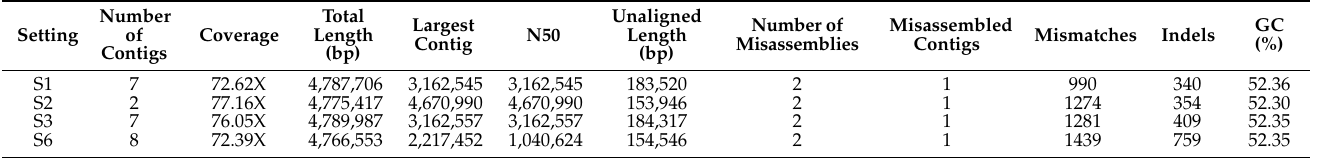
Table 4. Results of QUAST assembly quality assessment against reference genome.